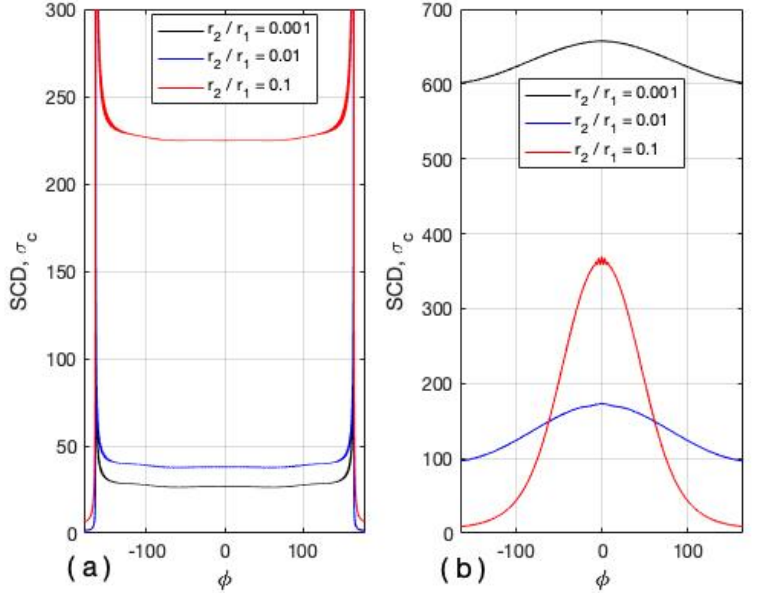
Figure 6. Surface current density (SCD) σ c ( φ ) for resonant excitation of the TM c 01 complex eigenmode over: ( a ) the cavity surface ( − 165 ◦ ≤ φ ≤ 165 ◦ , φ 0 = π /12); ( b ) the rod surface ( − π ≤ φ ≤ π ).